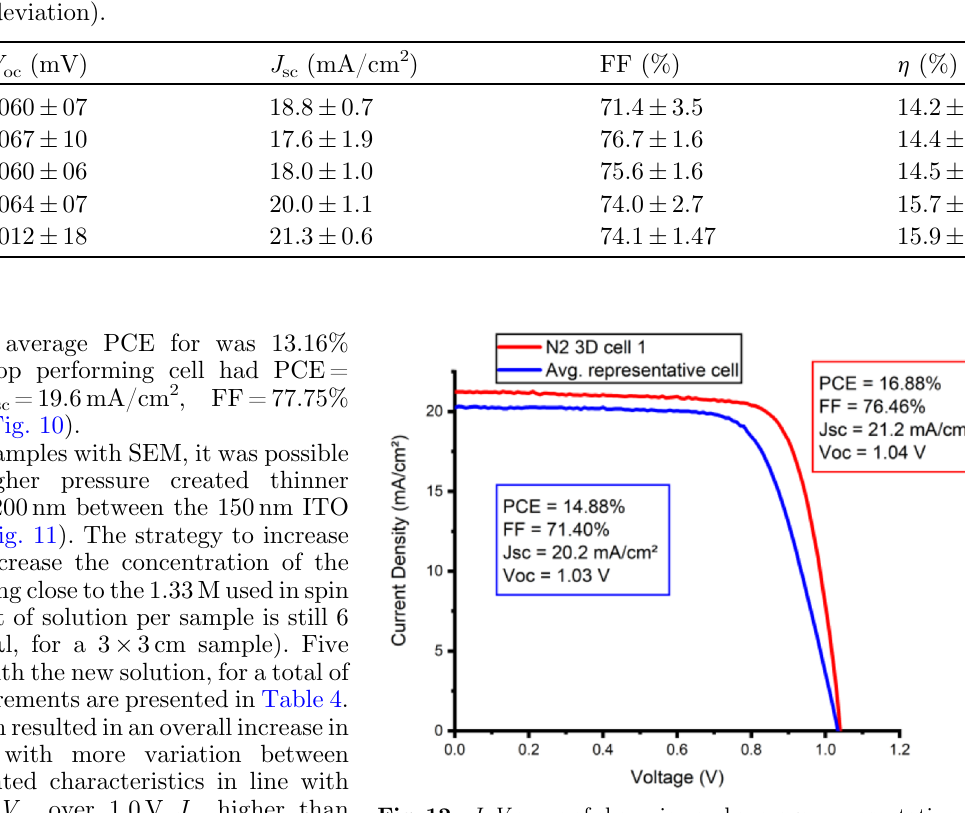
Fig. 12. J – V curve of champion and average-representative cells obtained with high pressure gas quenching and 1M solution. For the average-representative cell, the one with closest performance to the average values was